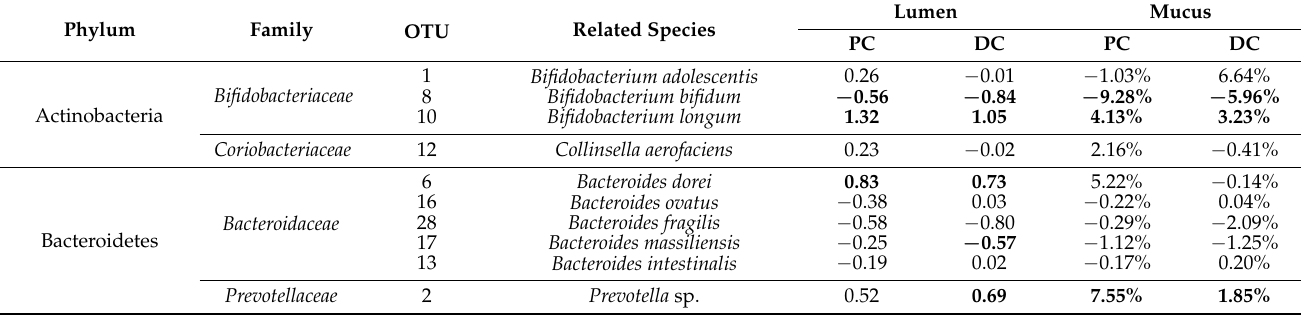
Table 2. Effect of cRG-I on microbial composition (25 most abundant OTUs across all samples) in the lumen (log cells/mL as estimated via multiplying total cell counts (cells/mL) with 16S rRNA gene profiling (%)) and mucus (%) of the simulated proximal (PC) and distal colon (DC) of the quad-M-SHIME. Values presented are the averages of the differences at the end of the treatment period (Day 35) versus those at the end of the control period (Day 14) across the four human adult donors tested ( n = 4). As a result, positive values indicate that a given OTU is increased upon cRG-I treatment. Statistical differences are indicated in